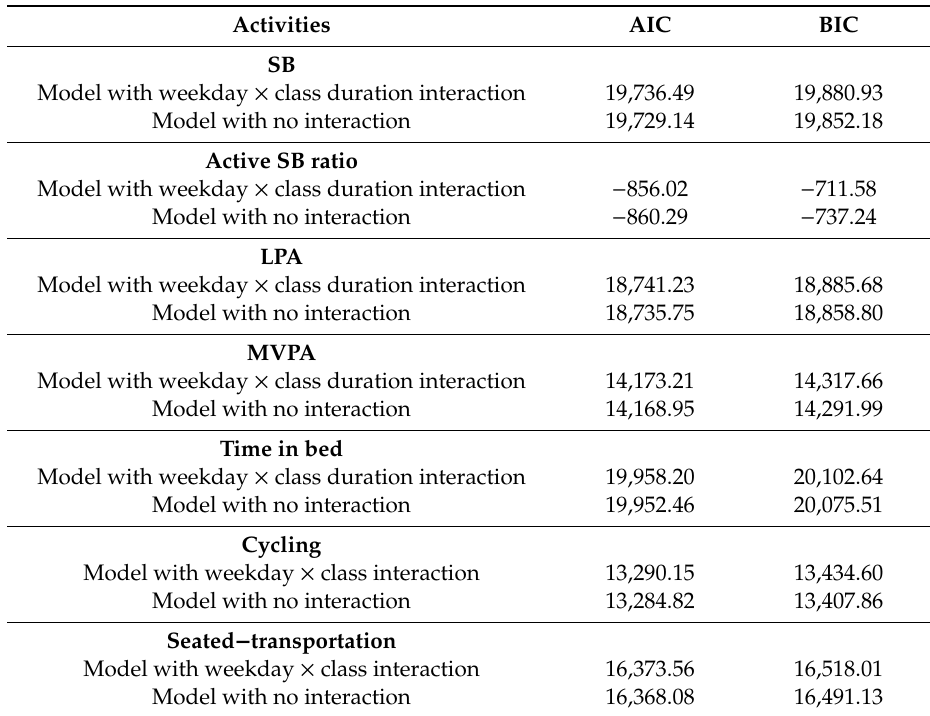
Table A2. AIC and BIC values indicating model goodness-of-fit.